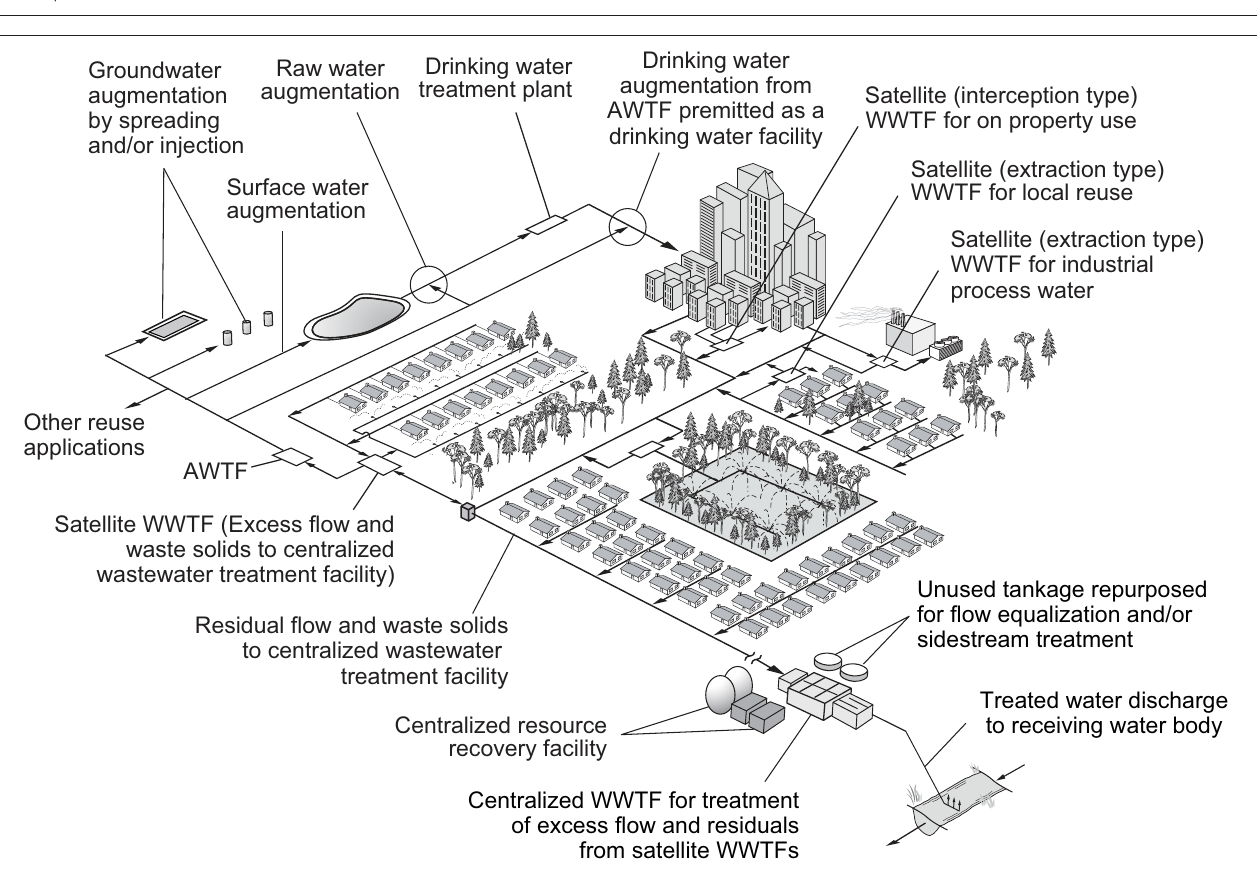
FIGURE 7 | Schematic view of an integrated wastewater management system employing satellite wastewater treatment facilities for local and potable reuse applications with residuals processing at a centralized WWTF [adapted from Gikas and Tchobanoglous (2009)].